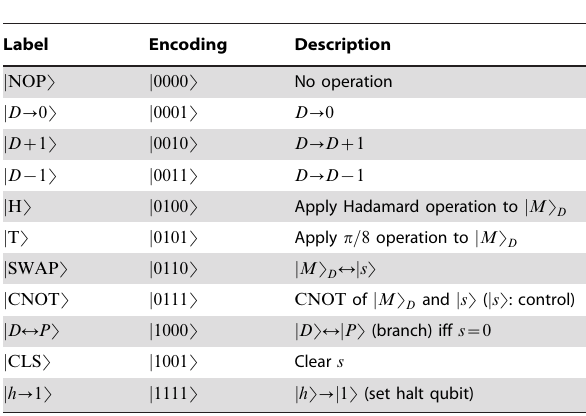
Table 1. UQC Instruction